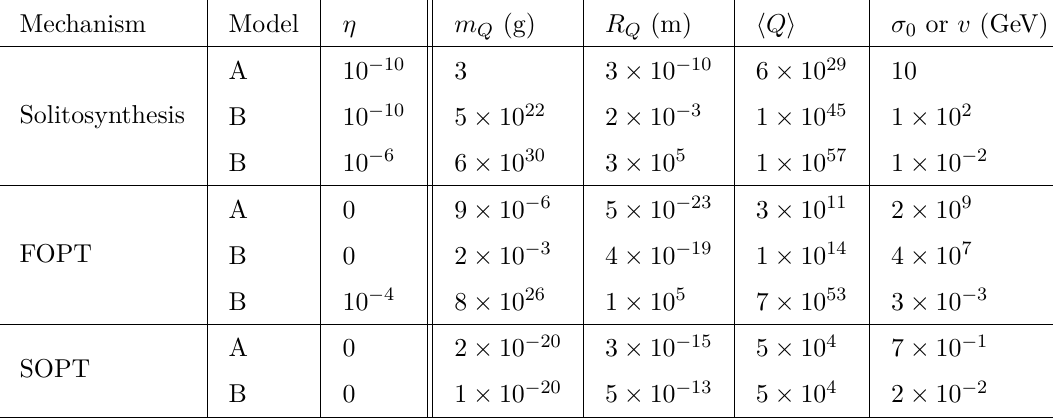
Table 1 . Benchmark Q-ball properties in Models A and B as produced from solitosynthesis or a PT making up all of dark matter (except solitosynthesis of Model A, see text). For the FOPT, a = 10 − 1 is assumed. Model parameters are chosen as in (2.11) with Q min = 4 , except the SOPT where λ = λ φ = 10 − 3 is used. The benchmark points with the largest masses for solitosynthesis and FOPT were chosen to demonstrate the full range of possible properties, but they are excluded by microlensing searches from making up all of dark matter